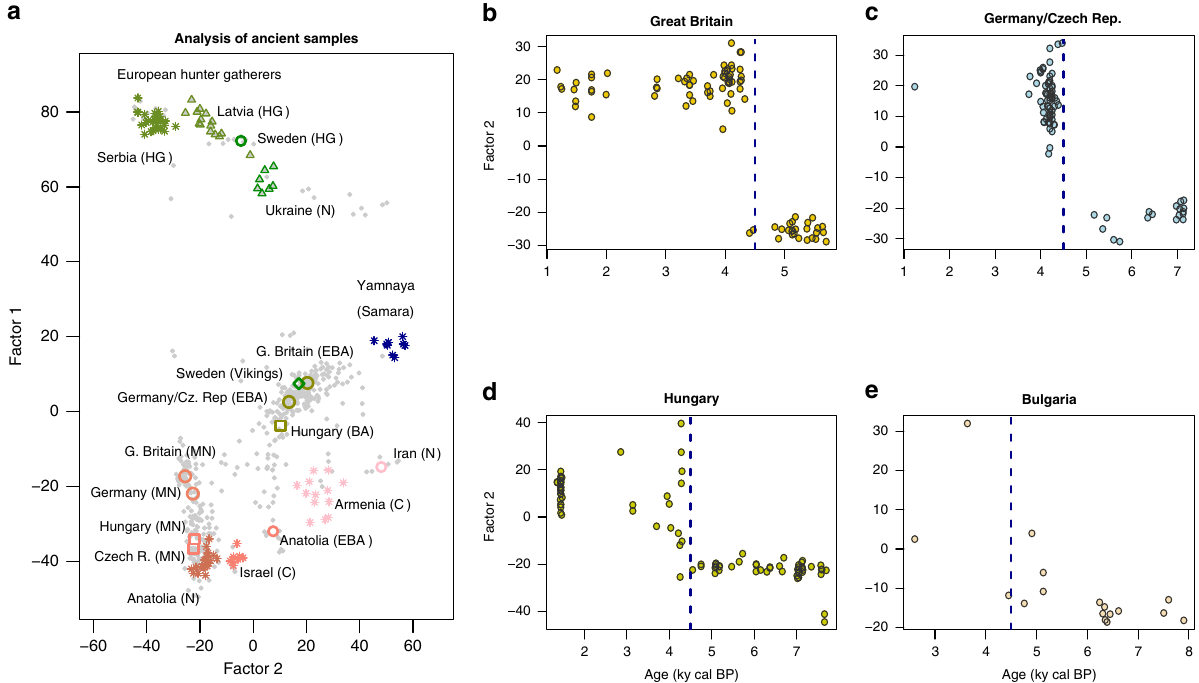
Fig. 3 Factor analysis of ancient European genomes. a Factor analysis of 704 ancient Eurasian individuals with ages ranging between 0.4 and 14 ky BP. Factor 1 separates western hunter-gatherers (Serbia) from early farmers (Anatolia), while factor 2 corresponds to steppe ancestry. b – e Factor 2 as a function of age for samples from four geographic regions. The FA supports a major change in genetic mixture of samples from Great Britain and Central Europe around 4500 years BP (dashed line). HG: Hunter-Gatherers, N: Neolithic, MN: Middle Neolithic, C: Copper Age, EBA: Early Bronze